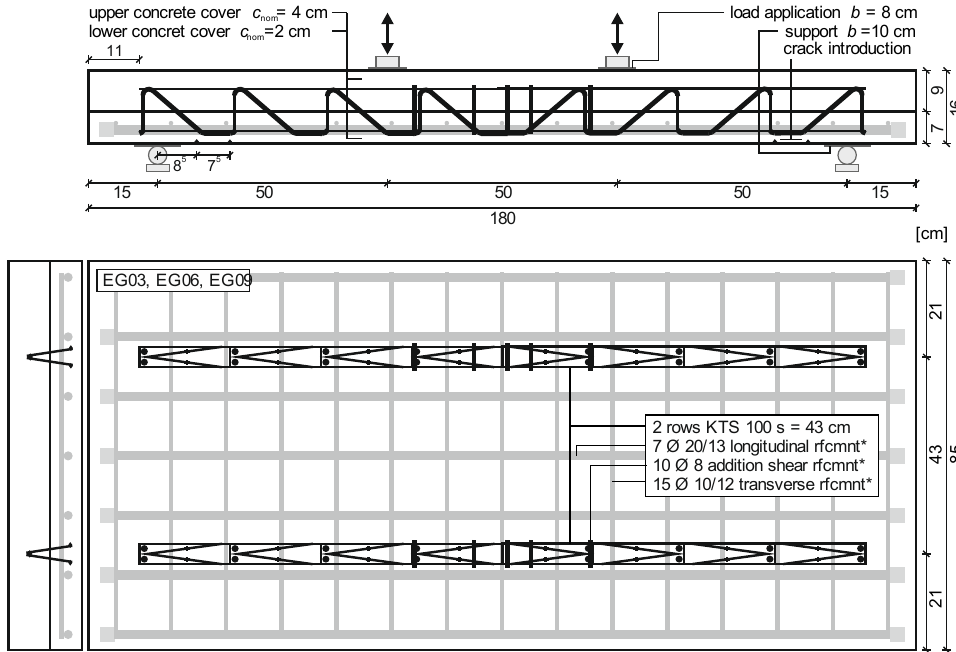
Figure 13. Reinforcement detail of Specimens EG03, EG06, and EG09.